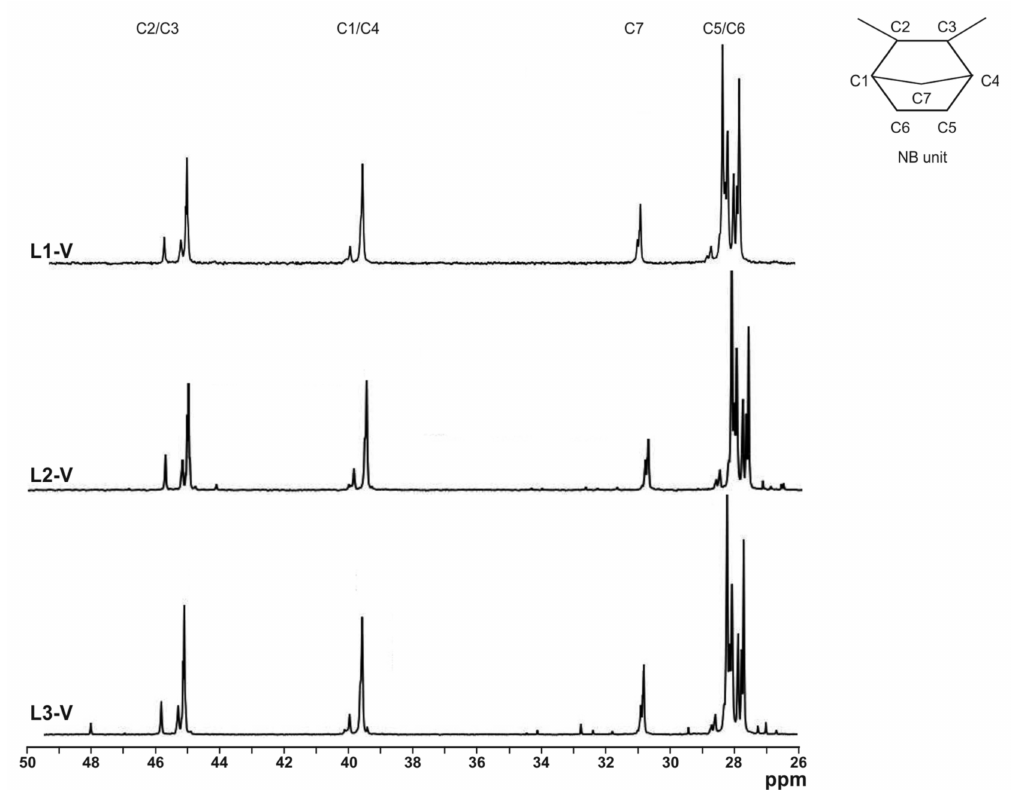
Figure 3. 13 C NMR spectra of ethylene-norbornene copolymers in o -dichlorobenzene-d4 (Table 1, items 3, 7, 11, Figures S34, S37 and